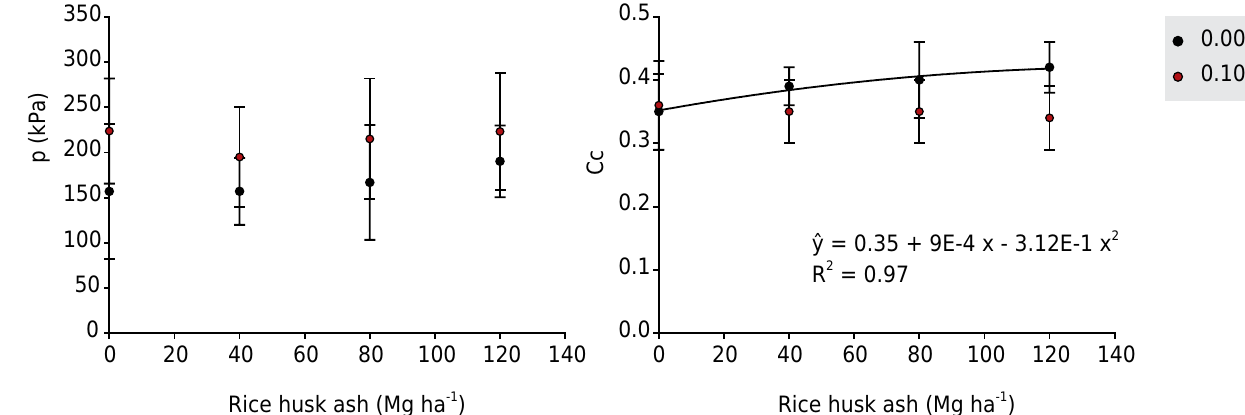
Figure 8. Precompression stress (σ p ) (a) and compressibility coefficient (Cc) (b) of a Typic Hapludult under different rates of rice husk ash in the 0.00-0.10 and 0.10-0.20 m layers. Vertical bars indicate the standard deviation.